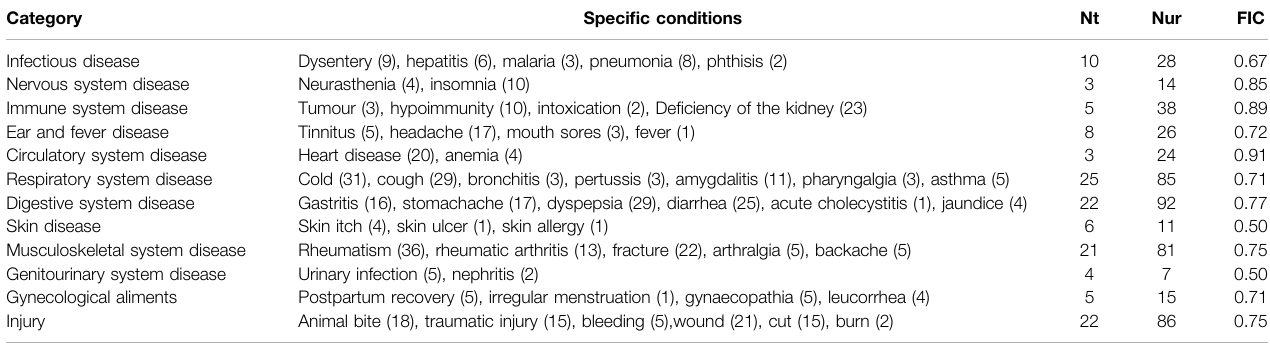
TABLE 3 | Informant consensus factor by categories of diseases in the study area.